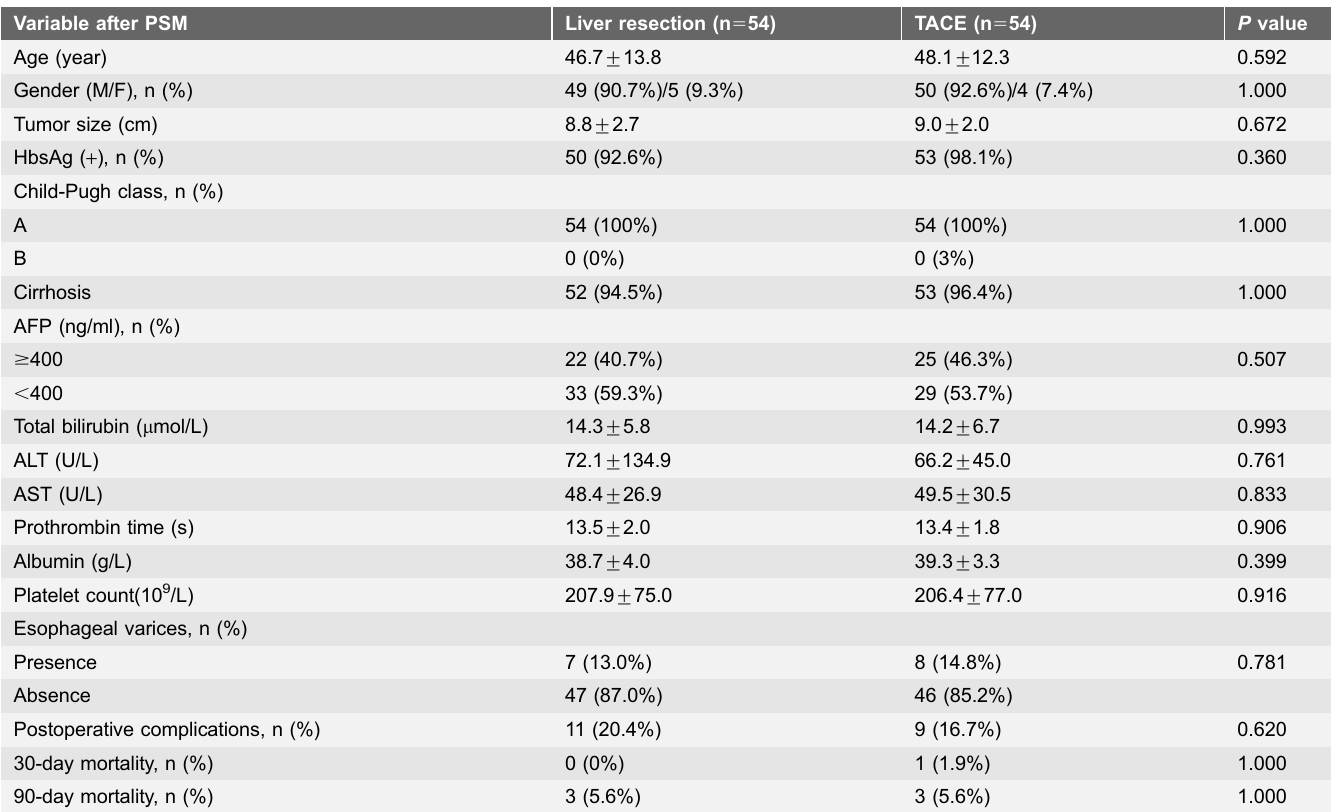
Table 2. Comparison of preoperative clinicopathologic data of patients receiving liver resection (LR) or transarterial chemoembolization (TACE) after propensity score matching (PSM).